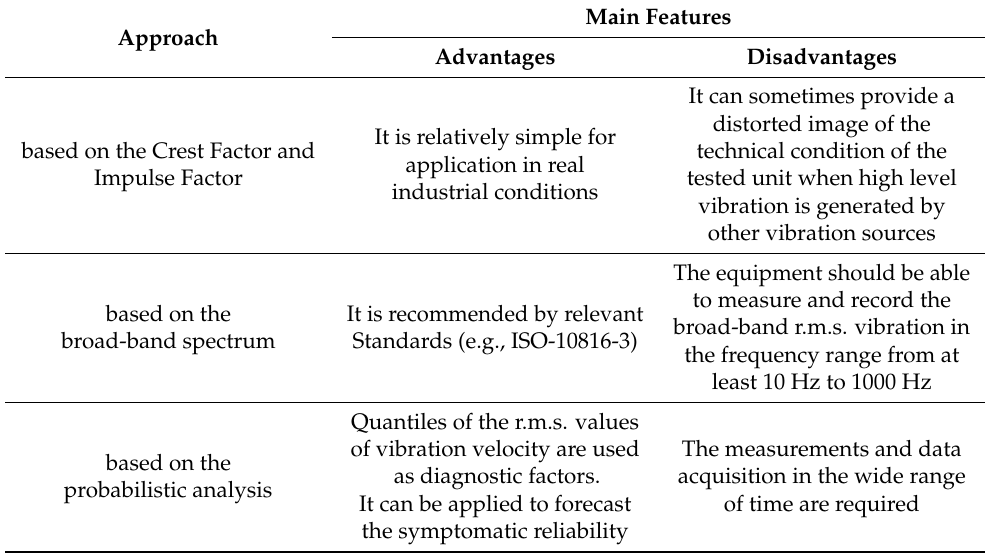
Table 4. Short characterization of the diagnostic methods applied by the